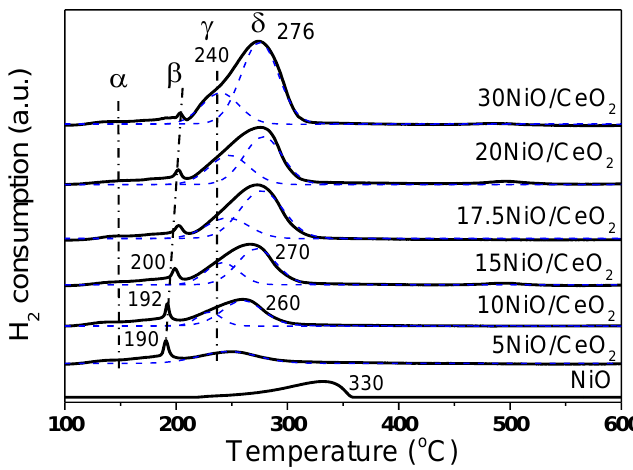
Figure 3. H 2 -TPR profiles of xNiO/CeO 2 precursors.